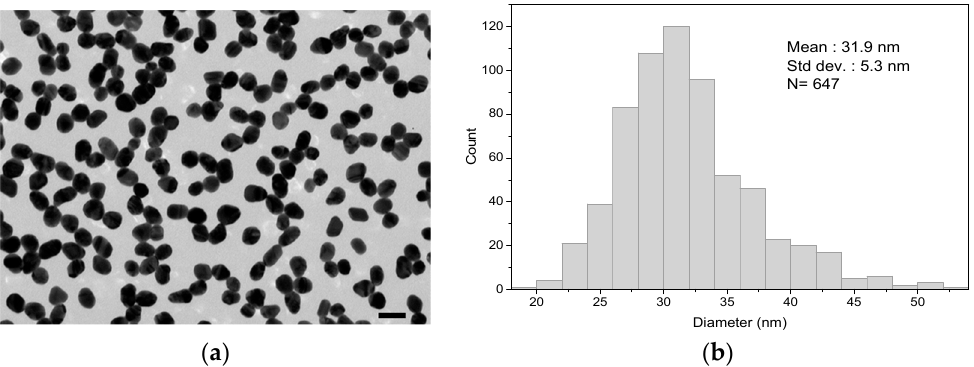
Figure 1. ( a ) Representative TEM images and ( b ) size distribution histogram of the PEGylated gold nanoparticles (AuNPs) used in the present study: 647 nanoparticles were manually measured to obtain this distribution. Scale bar in the right bottom corner of (a): 50 nm.